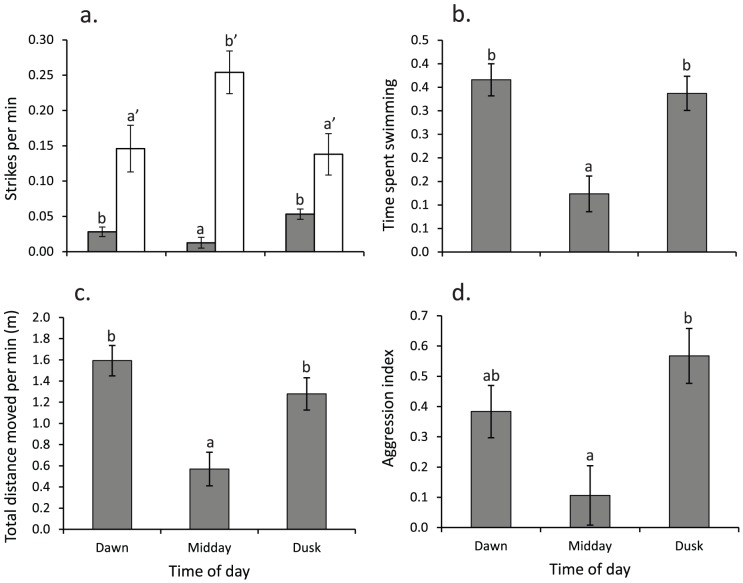
Diel variation in behaviour of Cephalopholis cyanostigma and Pseudochromis fuscus (means ± SE) for three times of the day: dawn, midday, and dusk.a) Total strikes per minute at fish for C. cyanostigma (dark grey bars) and P. fuscus (white bars), b) proportion of time spent swimming (as opposed to hiding and stationary) by C. cyanostigma, c) total distance (m) moved per minute by C. cyanostigma, and d) aggression index (+ aggression, − avoidance) for C. cyanostigma. Letters above bars represent Tukey's HSD homogenous subsets. N = 26, 21, 23 for dawn, midday and dusk respectively for C. cyanostigma, while N = 6, 6, and 8 for P. fuscus. Note that the definition of the time intervals for the two species differ slightly (see text for details). Data for P. fuscus in Fig. 2a from Feeney et al. (2012).